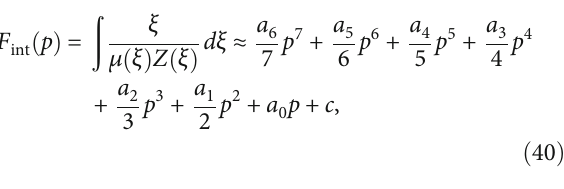
Figure 12: The estimated pro fi le of G